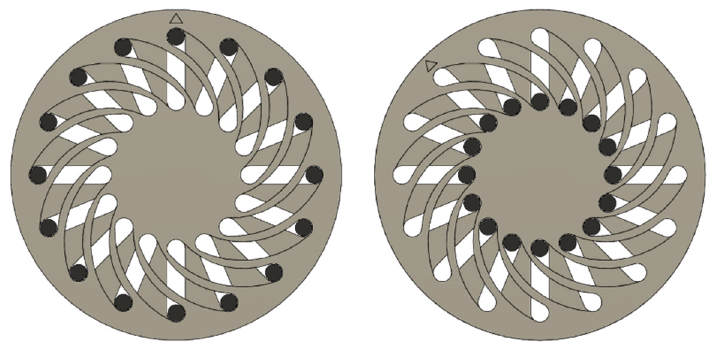
Figure 15. Maximum and minimum diameter of the bolts as a simplified representation of the mechanism. The triangle on the top disk indicates the disk turning 45° to the left.